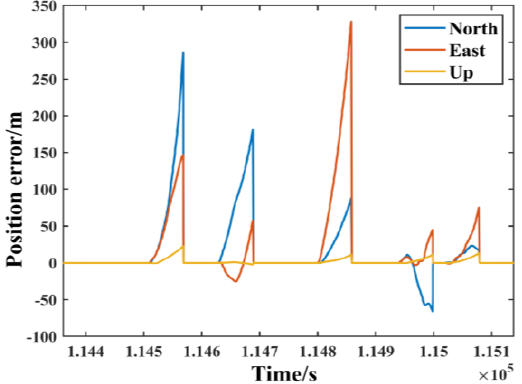
Figure 10. Positioning errors of classical GNSS/INS integration algorithm during GNSS outages in land experiment.